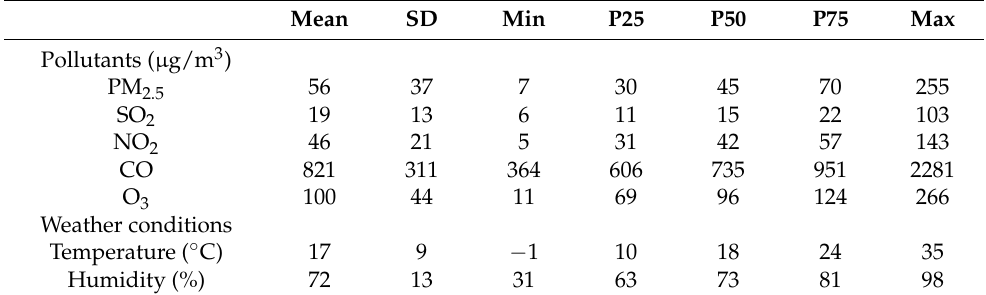
Table 1. The descriptive statistics of daily air pollutant concentrations and weather conditions in this